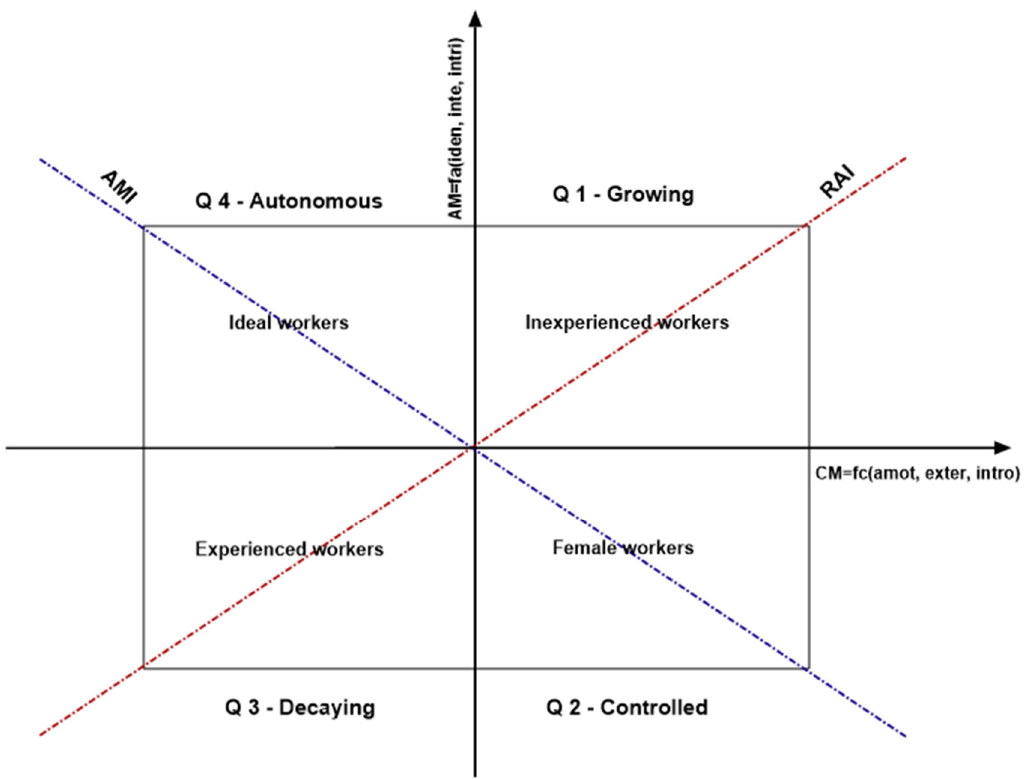
Figure 2. Motivation matrix.